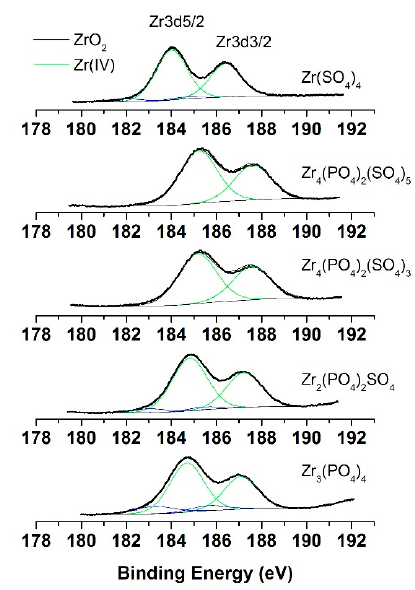
Figure 5. Zr3d XPS region for pure and mixed catalysts.